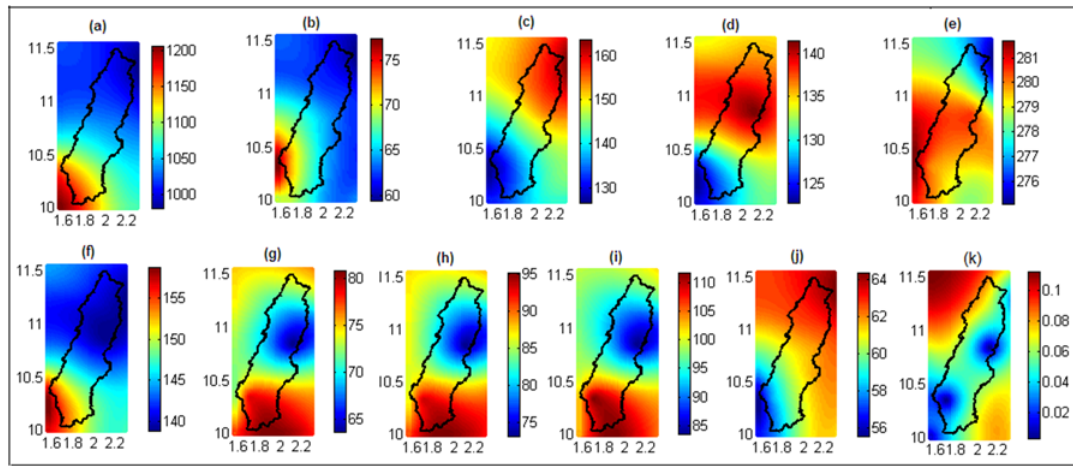
Figure 3 . Mean values of rainfall characteristics over the period 1981–2010 ( a : annual precipitation amounts (mm); b : number of wet days (day); c : dry spell length (day); d : onset of rainy seasons (Nth day of year); e : end of rainy seasons (Nth day of year); f : length of rainy seasons (day); g : maximum precipitation amounts during 24 consecutive hours (mm); h : maximum precipitation amounts during 48 consecutive hours (mm); i : maximum precipitation amounts during 72 consecutive hours (mm); j : total precipitation intensity of very wet days (%)) k : Kriging variance.